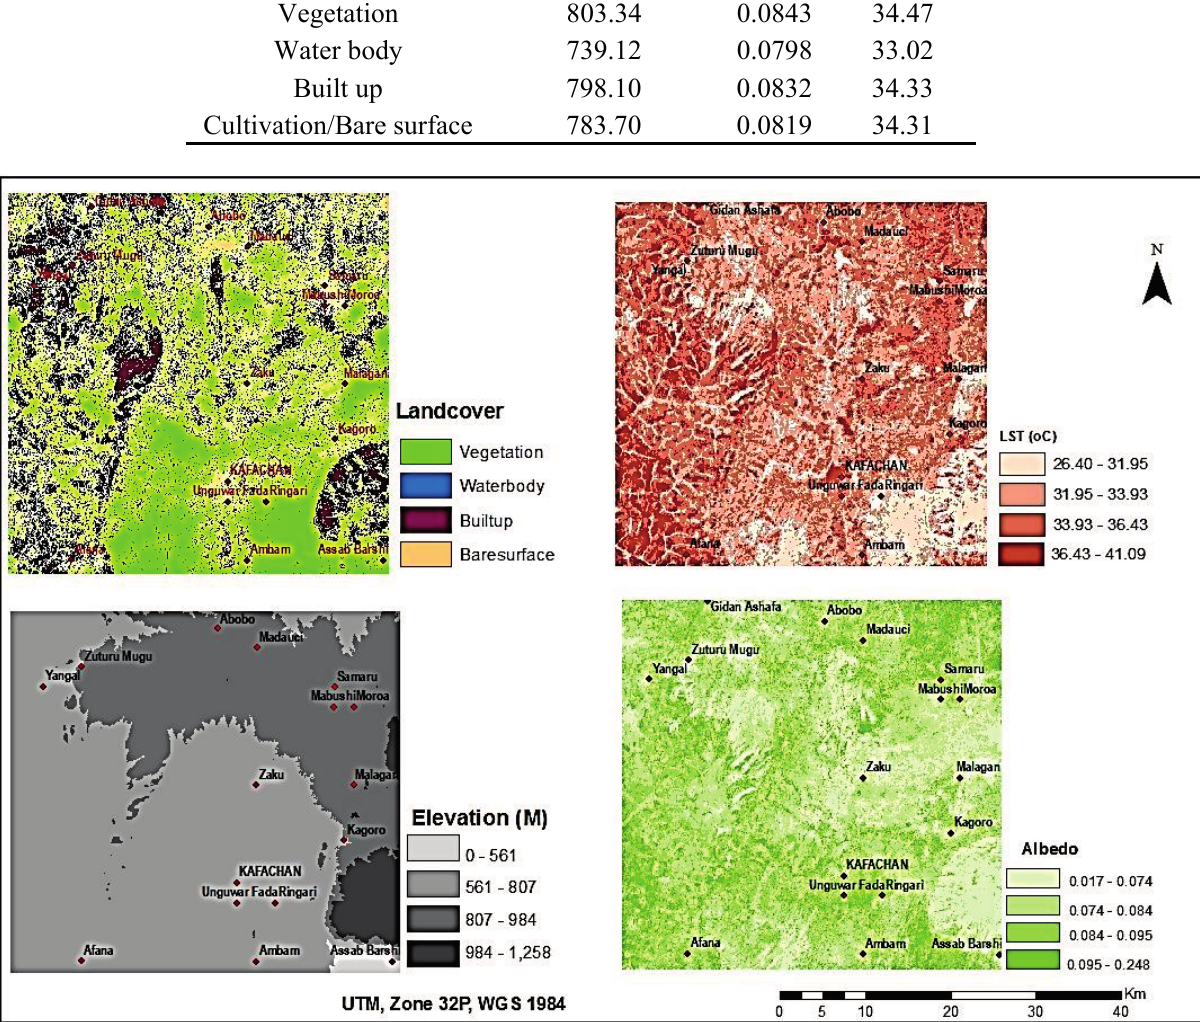
Table 8. Mean topography, mean albedo and mean LST across land cover types in Kafachan in 2014. Land Cover